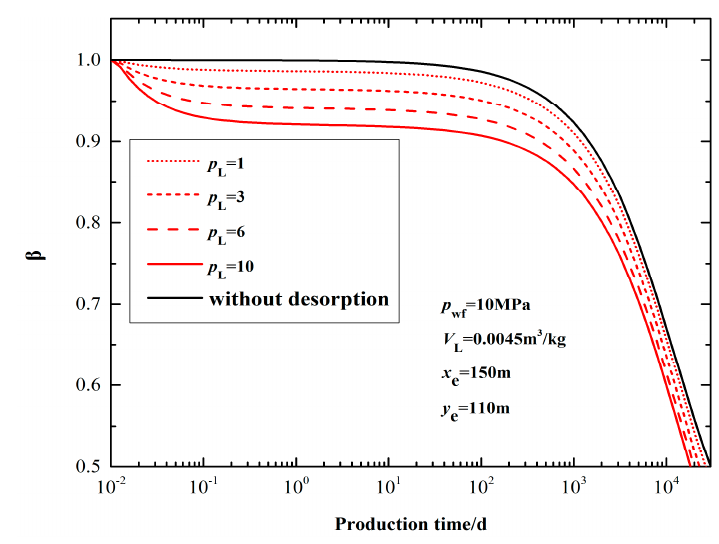
Figure 11. Effects of Langmuir pressure value on production behavior.